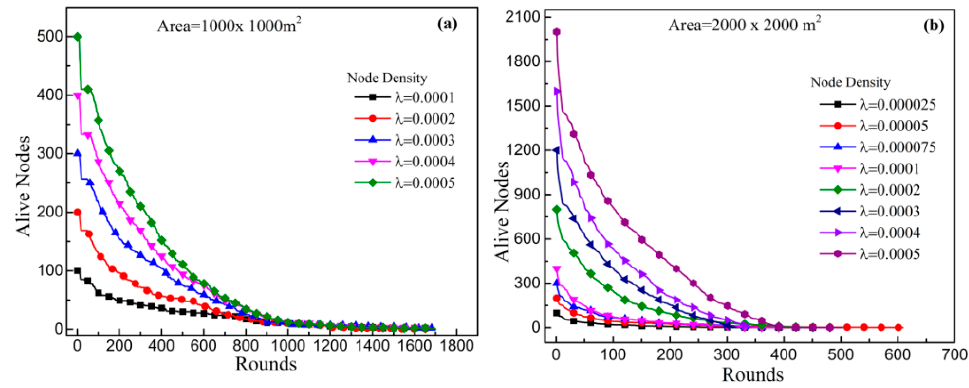
Figure 9. Number of nodes alive per round for MGBEHA protocol for different densities in ( a ) 1000 m × 1000 m, and ( b ) 2000 m × 2000 m area.